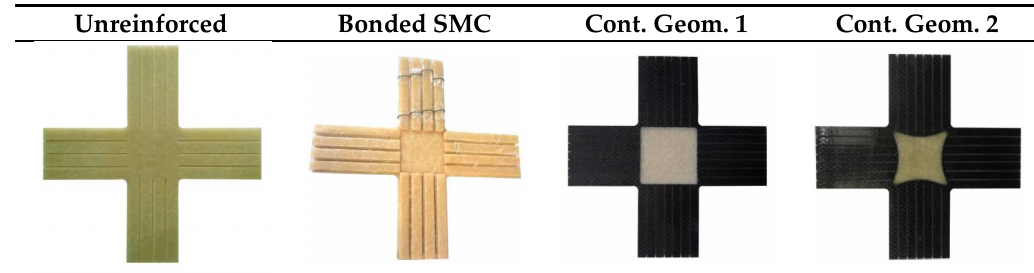
Table 1. Specimen designs.